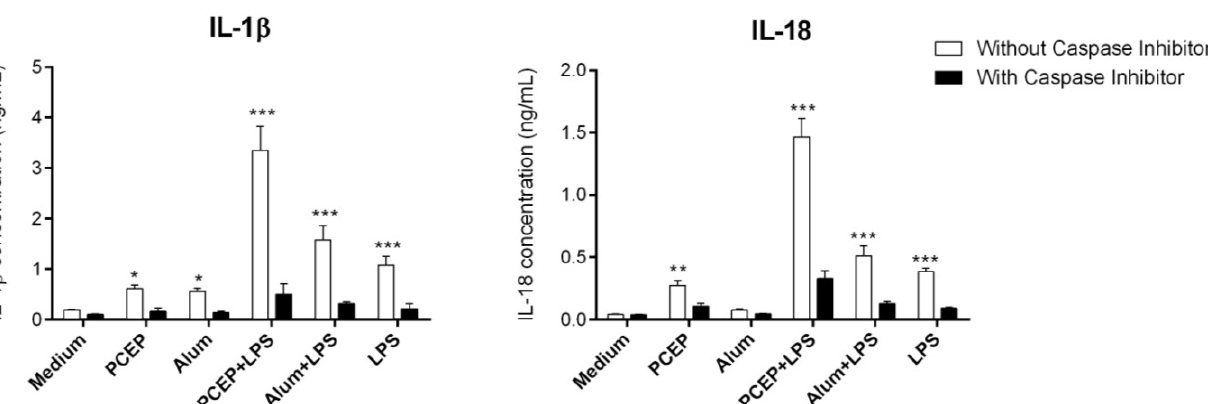
Figure 2. The role of caspase-1 in PCEP-stimulated IL-1β and IL-18 secretion. Enriched splenic dendritic cells (DCs) were treated with or without the caspase-1 inhibitor (CI) YVAD-fmk (40 μM) and then incubated with media, PCEP (50 μg/mL), alum (40 mg/mL), lipopolysaccharide (LPS) (0.1 μg/mL), PCEP+LPS or alum+LPS. Supernatants